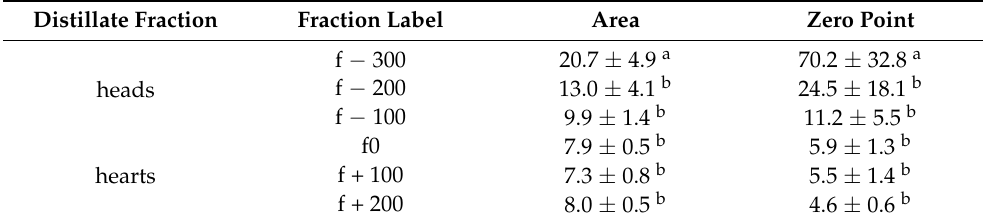
Table 4. Area-under-the-product absorbance curve and zero-point values of the calculated integrals. Integrals were evaluated via the according exponential function of heads and hearts subfraction spectra ( n = 3) with a lower bound of 230 and an upper bound of